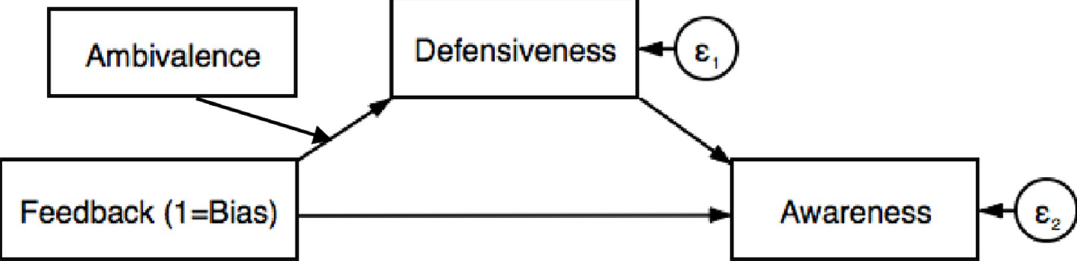
Fig 2. Conceptual model for SEM analyses. Conceptual model of the conditional indirect effect of implicit bias feedback (vs. no feedback) on bias awarereness via reduced defensive responding at both high and low levels of emotional ambivalence.